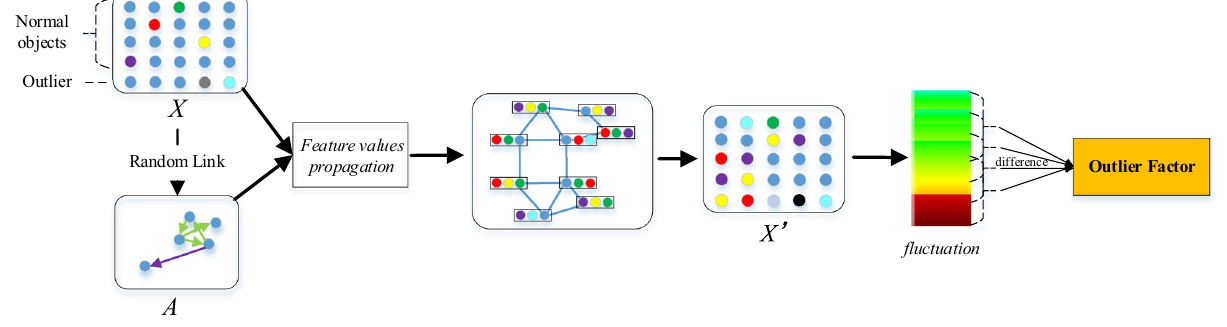
Figure 1. Illustration of the fluctuation-based outlier detection mechanism. FBOD compares the difference between the fluctuation of an object and its neighbors and determines the object with a larger difference as an outlier.